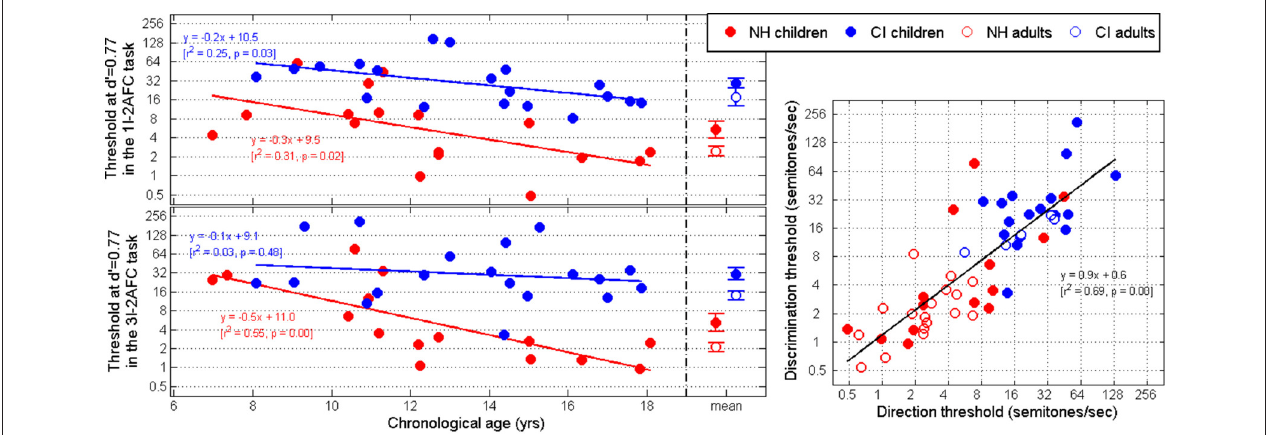
FIGURE 6 | Thresholds extracted at a d ′ value of 0.77 for the direction (top-left) and discrimination (bottom-left) tasks, as a function of the child’s chronological age. Adult data are represented only as means. (Right) Correlation between thresholds in the two tasks, including individual adult subject data.